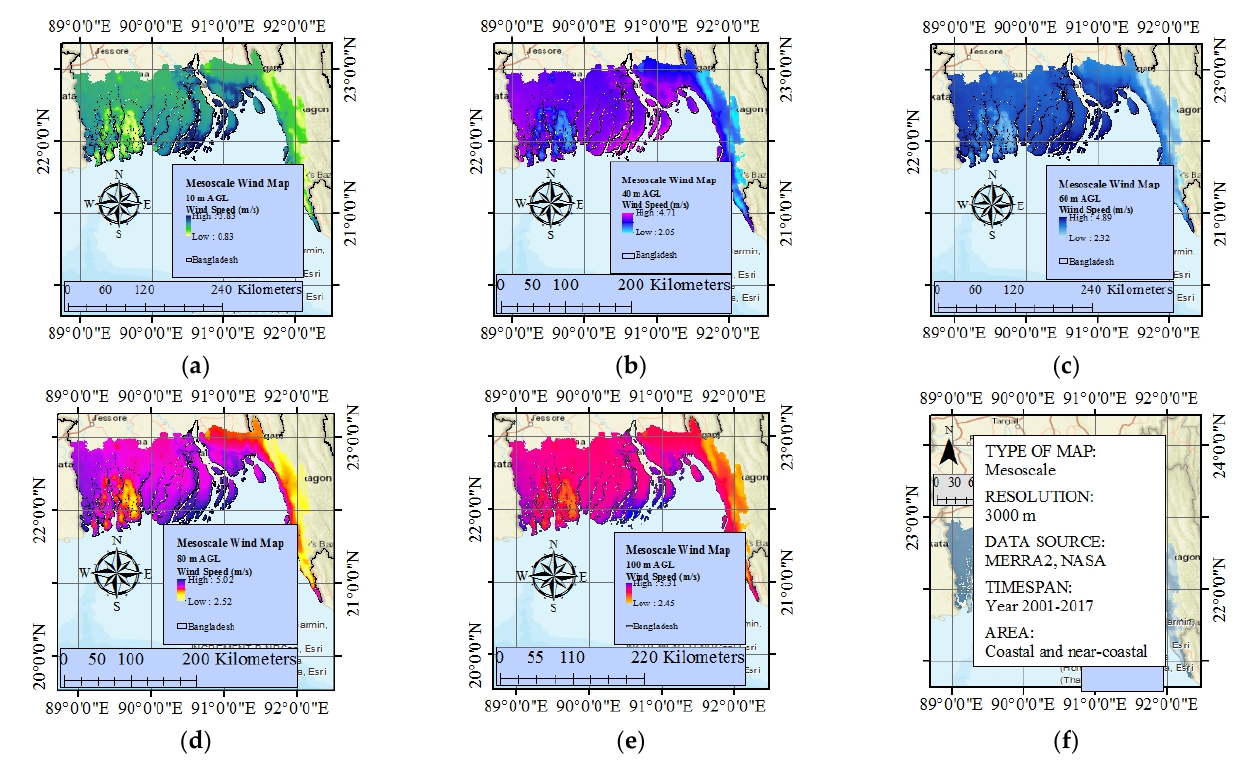
Figure 8. Mesoscale wind resource maps of the coastal and near-coastal areas of Bangladesh at ( a ) 10 m AGL, ( b ) 40 m AGL, ( c ) 60 m AGL, ( d ) 80 m AGL, and ( e ) 100 m AGL and the ( f ) map specifications. Table 7. The wind speed ranges of the mesoscale maps of the coastal and near-coastal areas of Bang- ladesh.